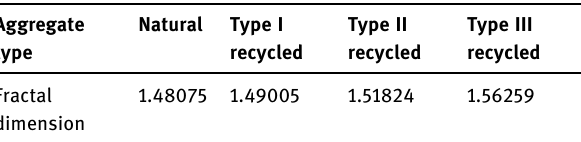
Table 7: Fractal dimension of boundary line of coarse aggregate particle group